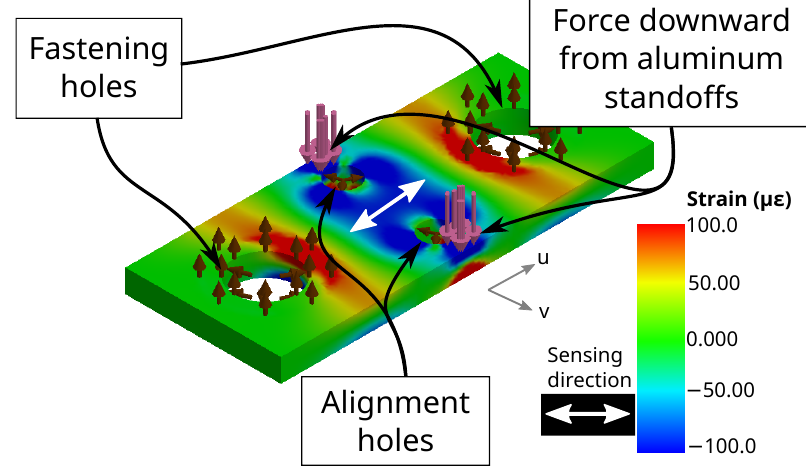
Figure 7. Sub-unit of the 3-DOF sensor with one strain gauge (indicated by the white arrow), two alignment pins, and two fastening holes. A 2.5N downwards force was simulated, represented by pink arrows at the edge of the sub-unit. Fixed surfaces on the holes are represented by brown arrows. Resulting strain of the sub-unit surface, with respect to the white axis in the u direction, can be negative and compressive (which is colored more blue) or can be positive and tensile (which is colored more